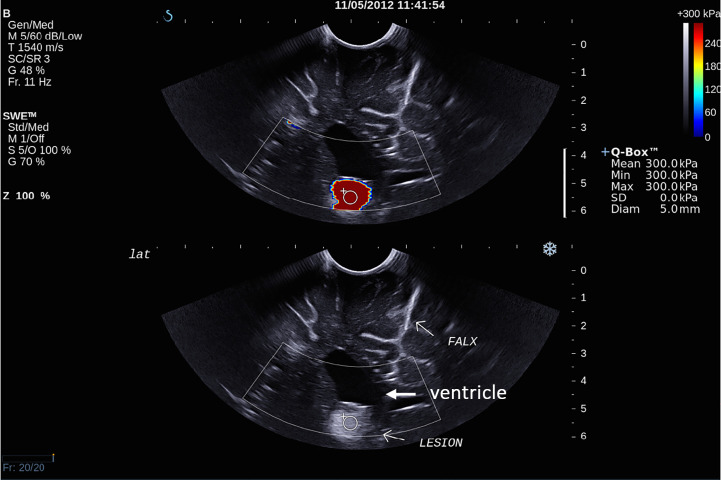
Intra-operative SWE for Patient 7 showing the tumor lying under the ventricles. The adjacent deep grey matter did not have any SWE signal. This scan was acquired using the sector probe (SE12-3) insonating in the coronal plane. The histology of this lesion is subependymal giant cell astrocytoma (SEGA).